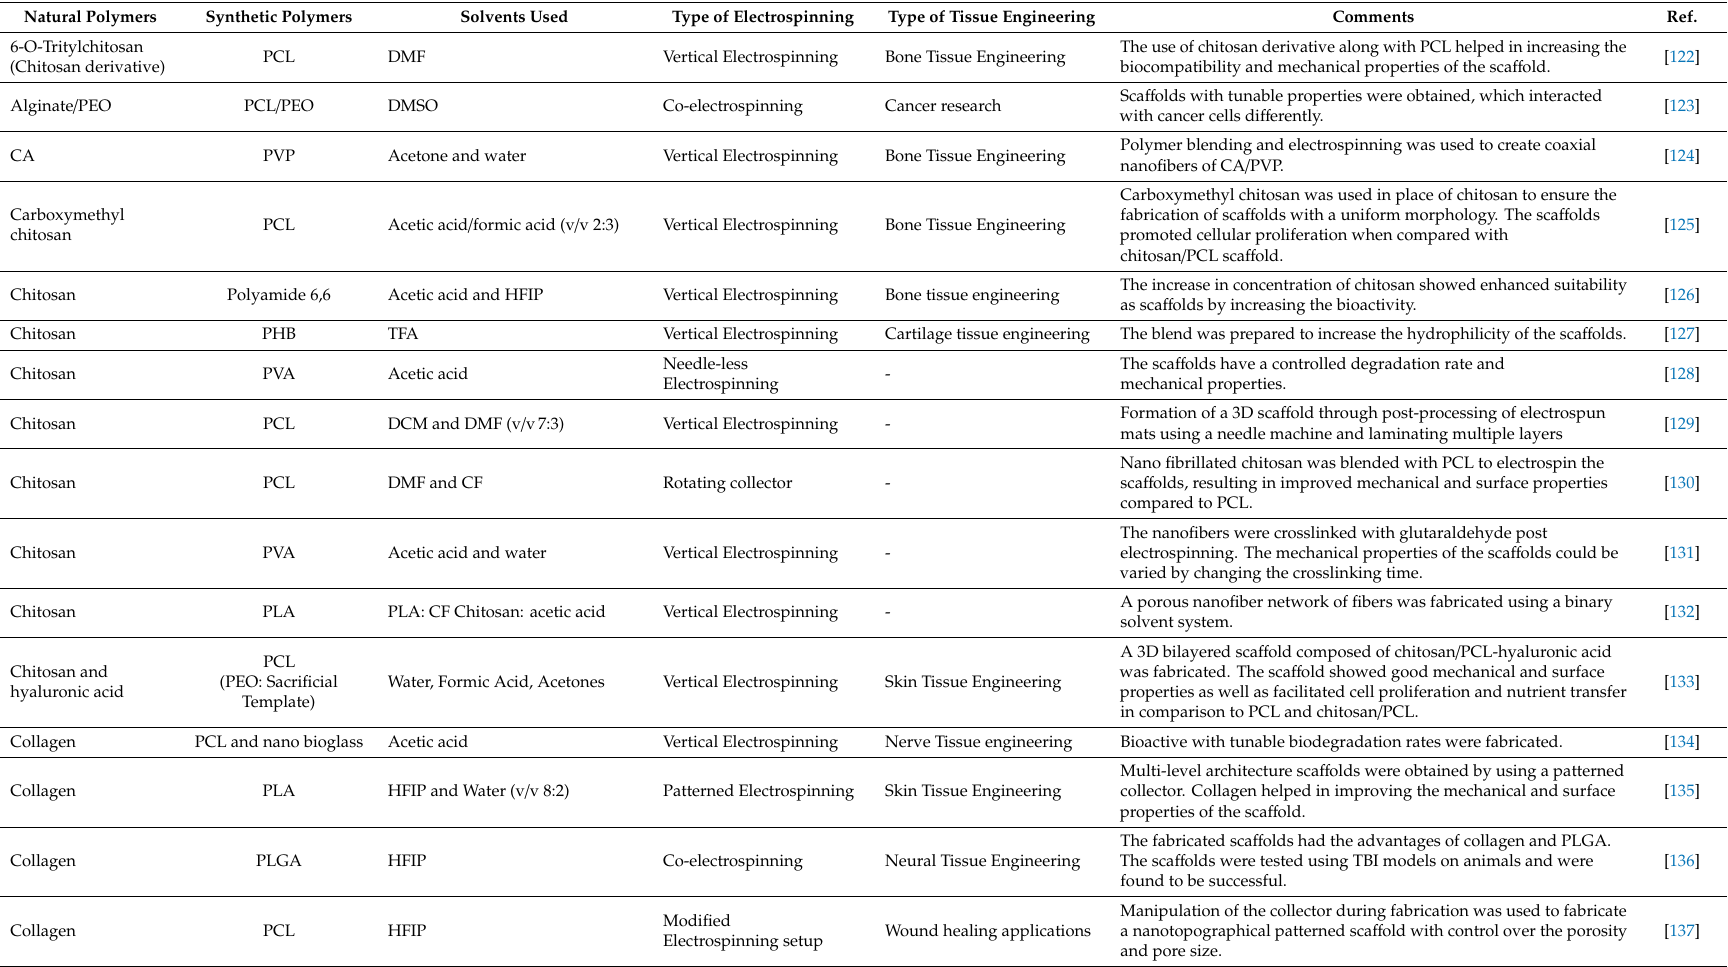
Table 4. Electrospun sca ff olds based on mixture of synthetic and natural polymer